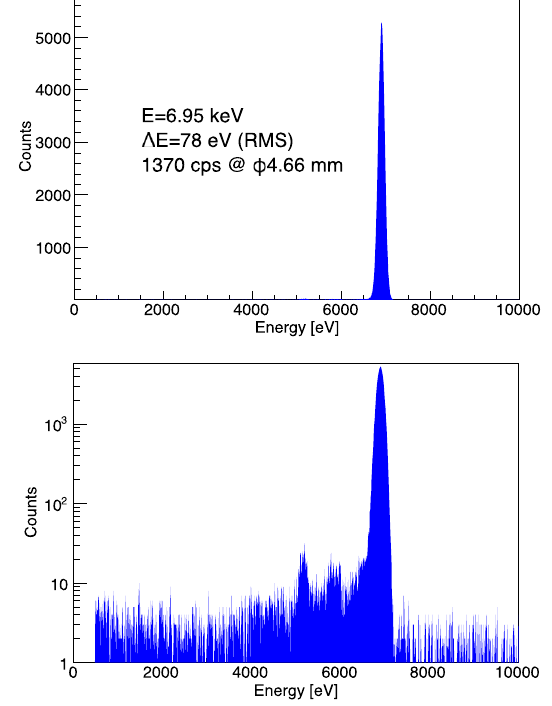
FIG. 25. Energy spectrum of the observed LCS photons with a linear scale (top) and a logarithmic scale (bottom).